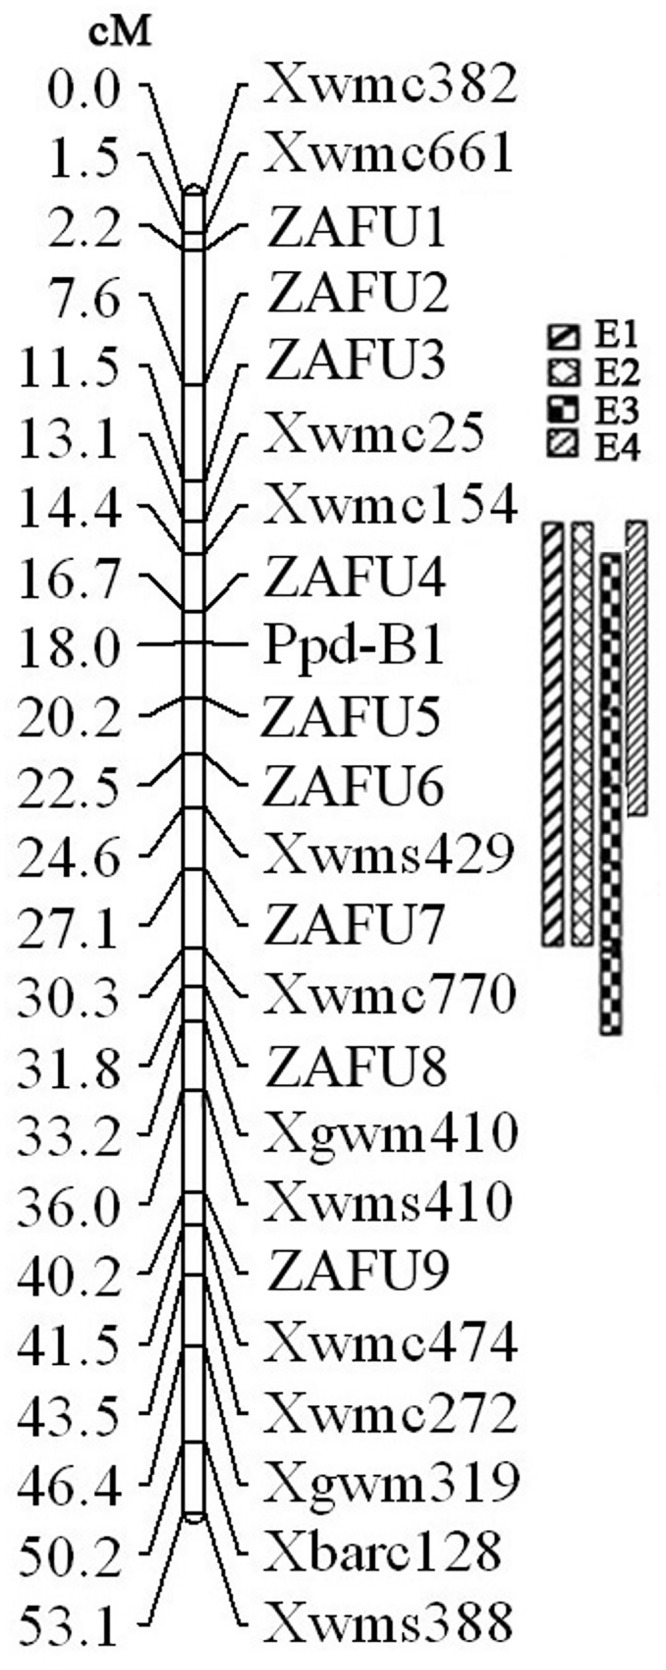
Linkage map of wheat chromosome 2BS constructed using segregation data from four F2 populations and locations of QTL related to heading date.